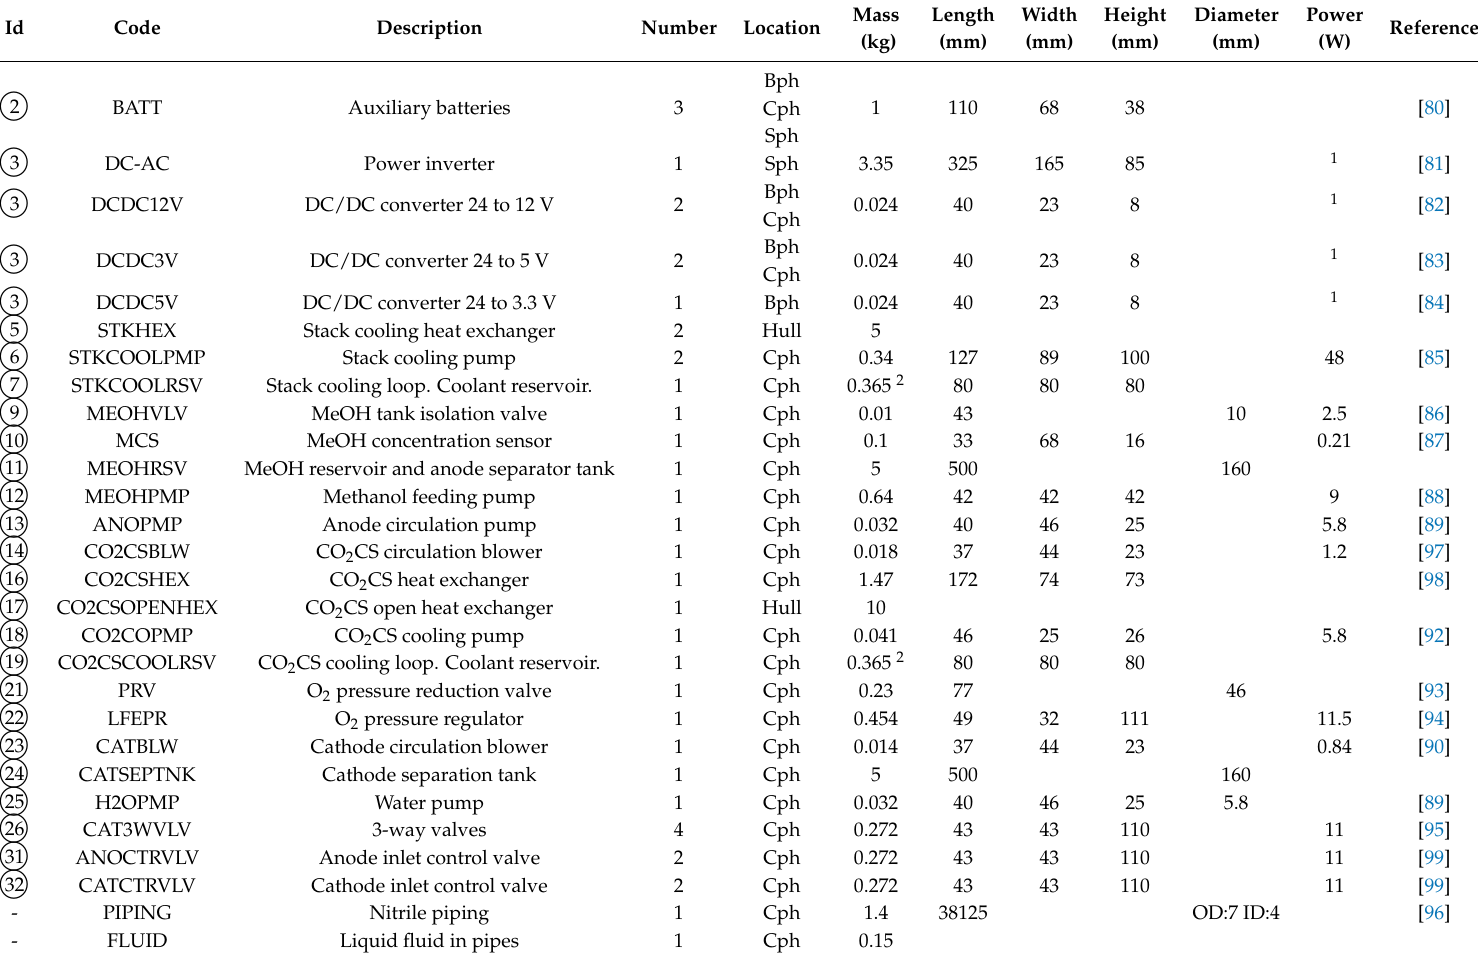
Table A4. BoP components characteristics for Model 3000 and Model 4500. Bph, bow pressure hull. Cph, central pressure hull. Hull, attached to the external hull. OD, outer diameter. ID, inner